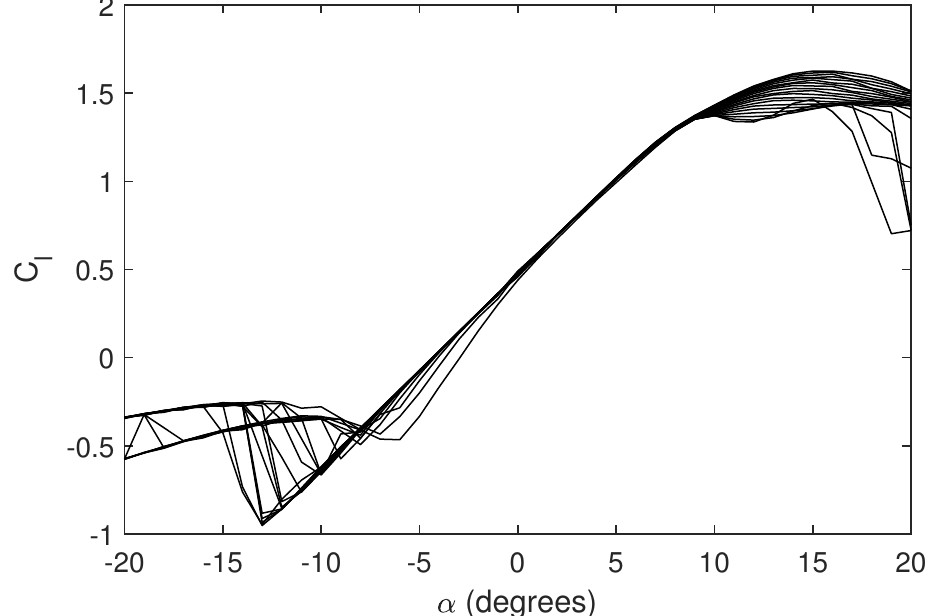
Figure A1. Lift coefficient from XFOIL at different Reynolds numbers ranging from 2 × 10 4 to 1 × 10 6 .